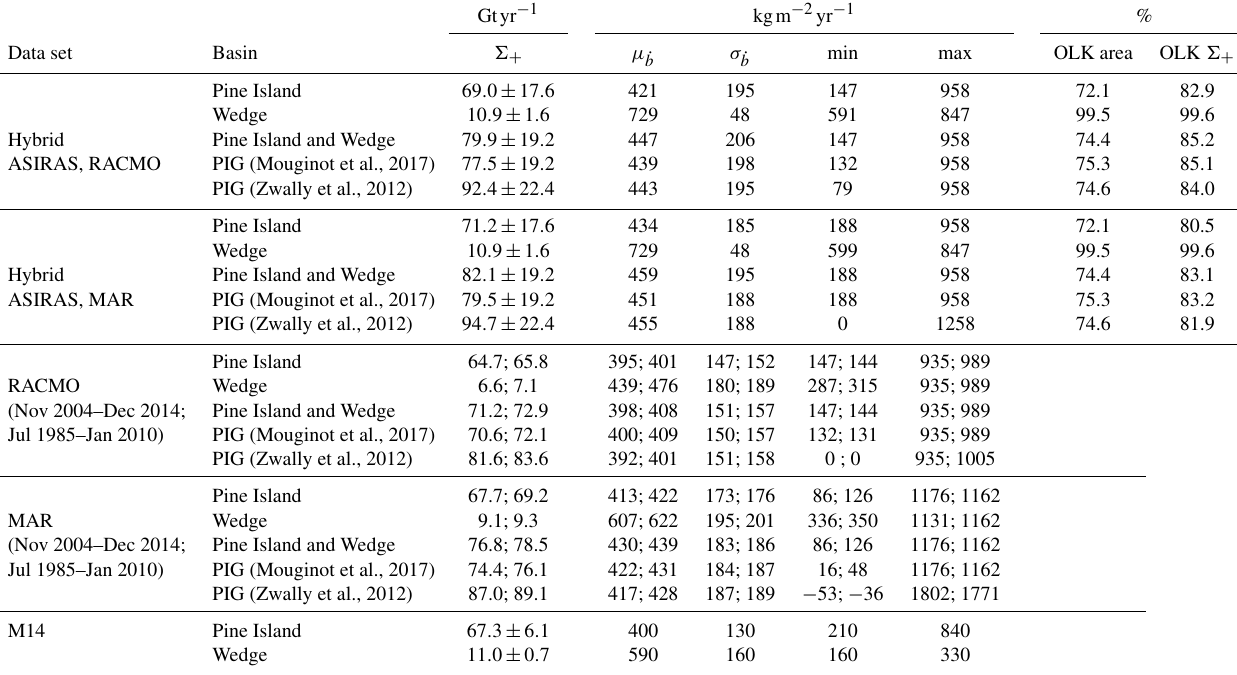
Table 3. Spatially integrated SMB ( (cid:54) + ), mean ( µ ˙ ), standard deviation ( σ ˙ ), minimum, and maximum SMB based on different data sets b b and basin definitions according to Fig. 9d. For the hybrid SMB estimates of this study, the areal contribution as well as the contribution of spatially integrated SMB from the ASIRAS estimates is denoted by OLK area and OLK (cid:54) + , respectively. In addition to the November 2004 to December 2014 averaging period of the hybrid estimates, RACMO and MAR estimates separated by semicolon refer to the July 1985 to January 2010 averaging period in accordance with the results from